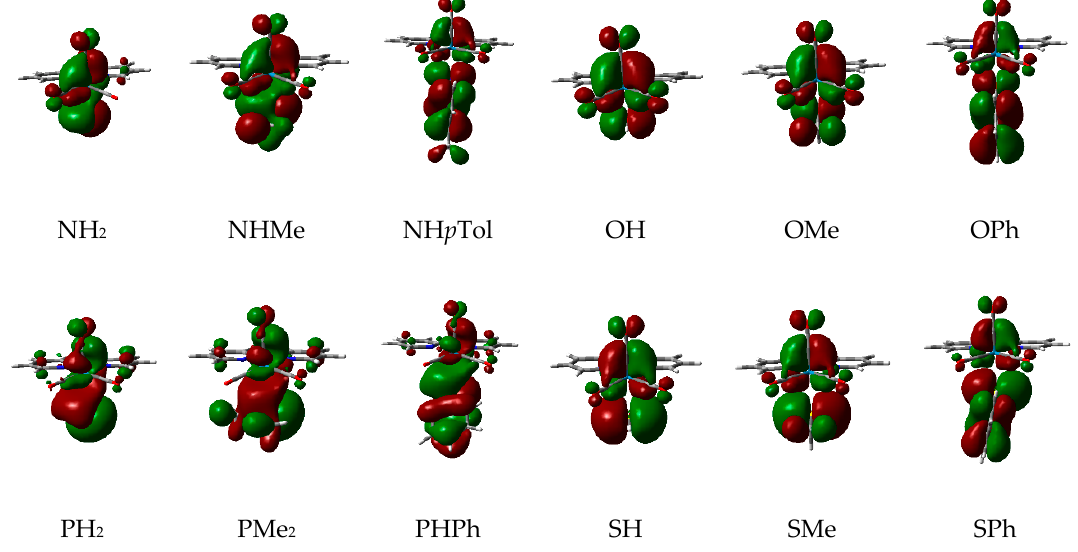
Figure 3. Pictures of the computed HOMO of the reactant complexes [ReY(CO) 3 (bipy)] (Y = NH 2 , NHMe, NH p Tol, OH, OMe, OPh, PH 2 , PMe 2 , PHPh, SH, SMe, SPh).